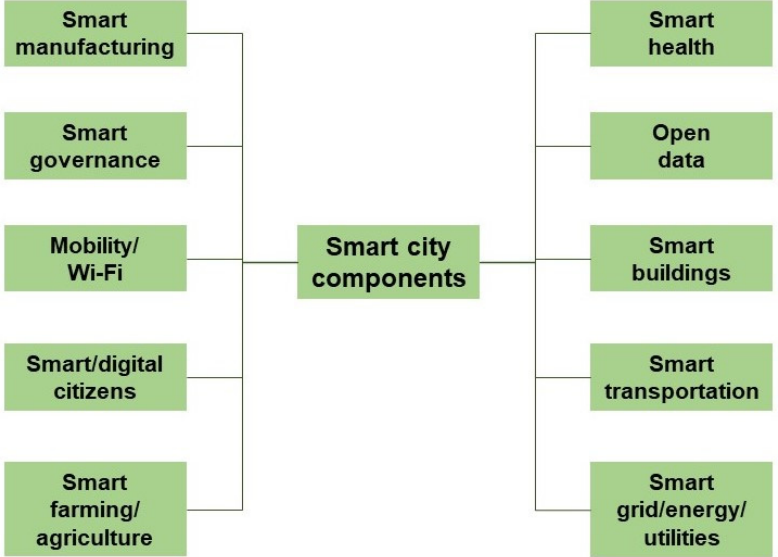
Figure 1. Components of a smart city. Source: Adapted from Reddy et al. (2018) [3].